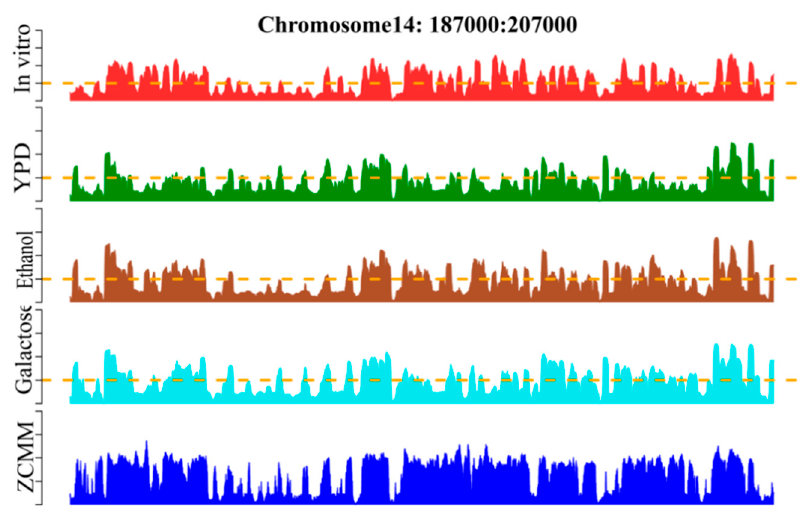
Figure 5. Illustration to show the nucleosome occupancy profile predicted by the ZCMM model on S. cerevisiae chromosome 14 (187000:207000). To facilitate the comparison, the corresponding profiles by experiments are also shown. In a top–down order, they are the genomic position on the chromosome, the experimental map in vitro, and the experimental maps in vivo for YPD, Ethanol, and Galactose, respectively. Depicted in the lowest panel is the nucleosome occupancy profile determined by the proposed ZCMM.